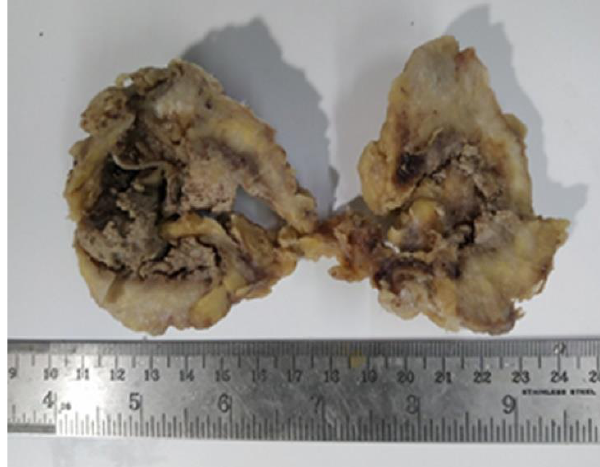
Figure 2 : Gross Specimen showing cavity like